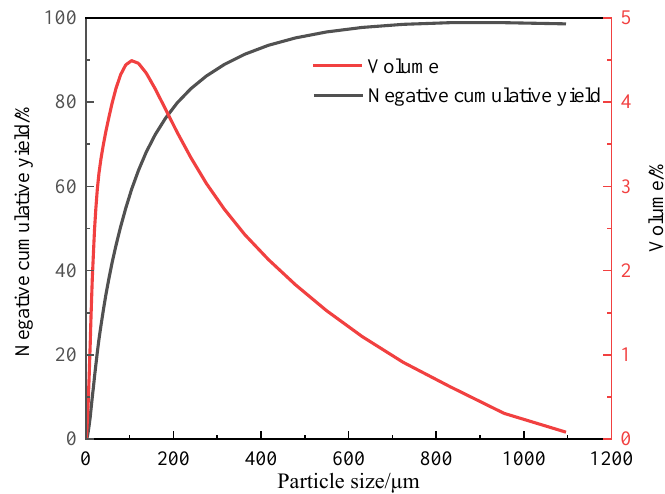
Figure 1. Characteristic curve of particle size of material.